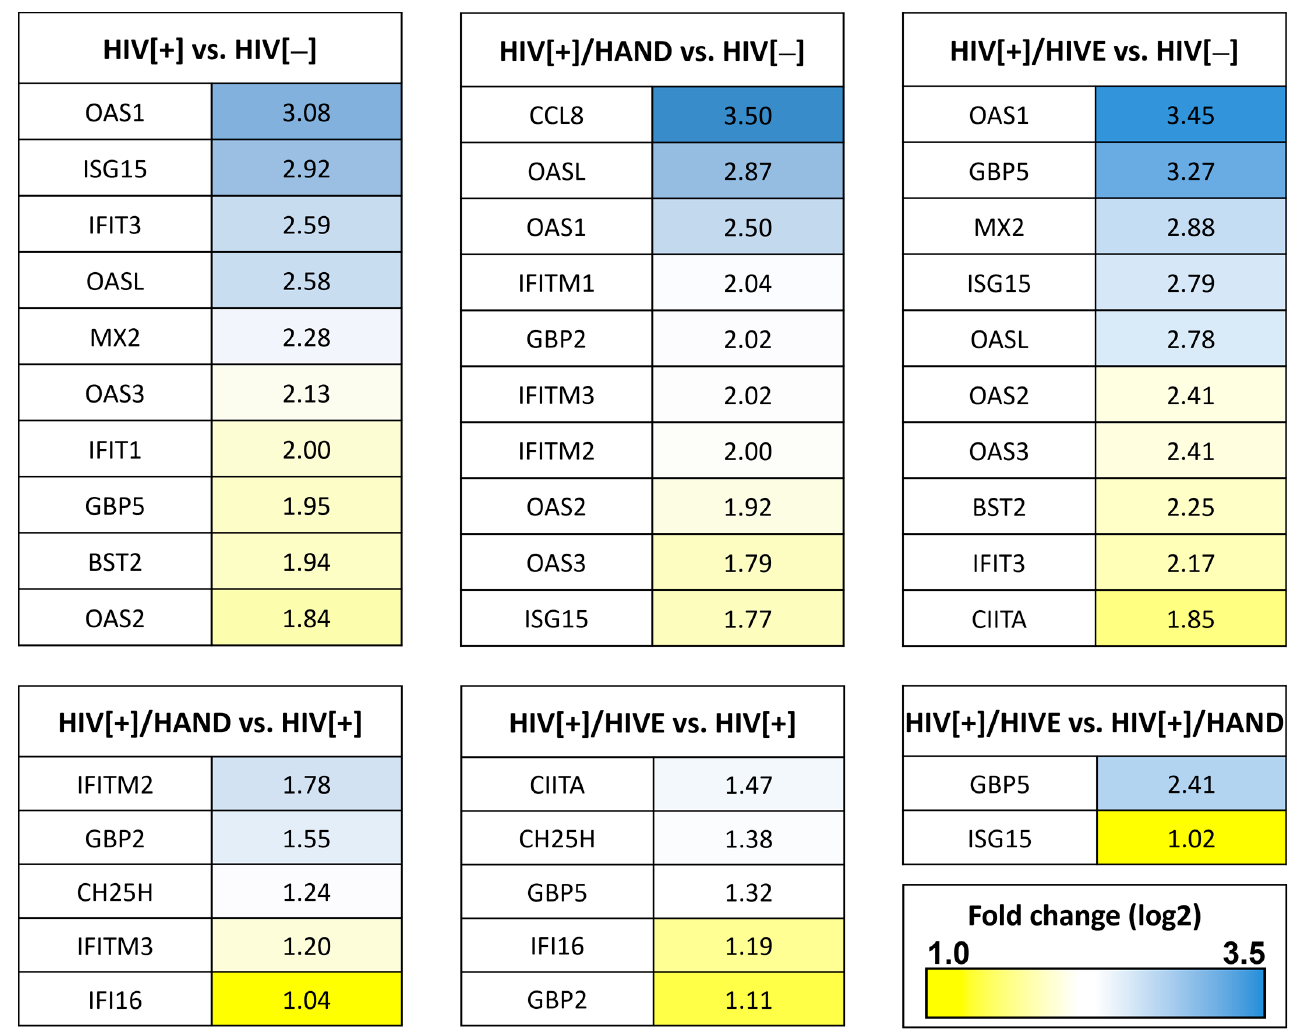
Figure 3. Heat map of upregulated host restriction factors in different experimental groups. The top upregulated genes ( n = 10) were selected from each of the HIV[+] groups compared to the HIV[ − ] group derived from the RNA-seq database. For the comparisons within HIV[+] groups, with or without HAND, the top upregulated genes with a minimum 1.0 log2 fold change were selected. Quantitative Reverse Transcription PCR (qRT-PCR) was used to validate the differ- ential expression of the selected genes. The relative mRNA expression of the majority of these genes— GBP2 , GBP5 , IFITM1 , IFIT1-3 , CIITA , CCL8 , IFI16 , OAS1-3 , OASL , RNASEL , MX2 , and ISG15 —was higher in the HIV[+]/HIVE group compared to the HIV[ − ] and HIV[+] groups (Figure 4). IFITMs (interferon-induced transmembrane proteins) inhibit the entry/fusion of some enveloped viruses, including HIV, by changing the physical char- acteristics of the plasma membrane of the host cells [63,64]. IFITM1 was upregulated in both HIV[+] groups with HAND, although this upregulation was statistically significant only in the HIV[+]/HIVE group compared to the HIV[ − ] ( p < 0.01) and HIV[+] ( p < 0.01) groups (Figure 4A). Interestingly, the IFITM2 gene was only upregulated in the HIV[+]/HAND group compared to the HIV[+] group ( p < 0.05) (Figure 4B). The IFITM3 mRNA expression levels did not differ among different groups (Figure 4C).